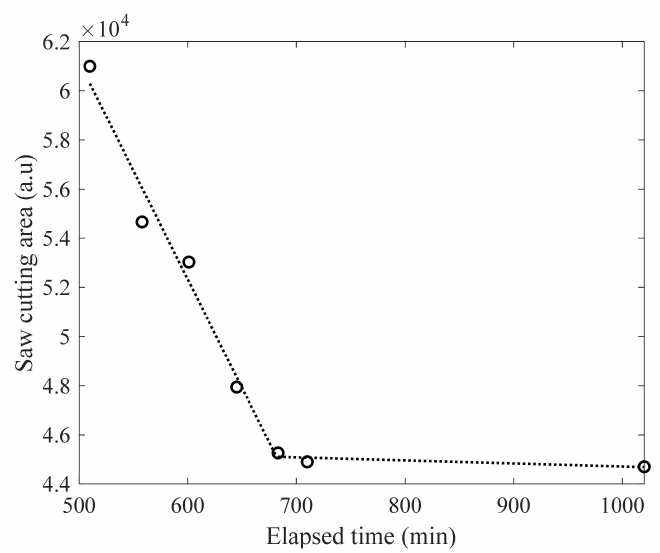
Figure 9. The obtained saw-cut areas indicating two distinct regions showing different slopes.